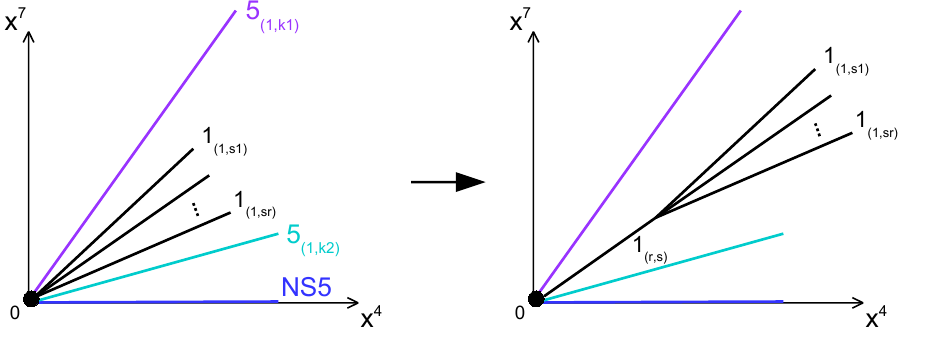
Figure 39 . When k 2 r (cid:20) s (cid:20) k 1 r , a setup with 1 strings, i = 1 ; (cid:1) (cid:1) (cid:1) ; r , k 1 (cid:20) s i (cid:20) k 2 , can be (1 ;s i ) deformed into a junction with a 1 string ending on the D3, with s = P ( r;s ) For 0 (cid:20) s (cid:20) k r the 1 string can arise from a junction with a collection of r 1 2 ( r;s )